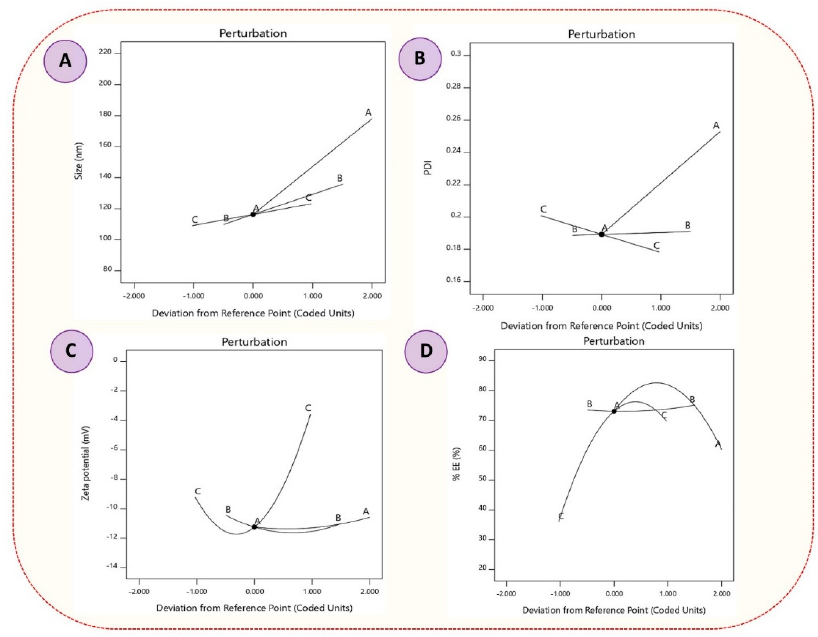
Figure 3. ( A - D ) Perturbation plots ( A ) PS, ( B ) PDI, ( C ) ZP and ( D ) %EE. Figure 3. ( A – D ) Perturbation plots ( A ) PS, ( B ) PDI, ( C ) ZP and ( D )